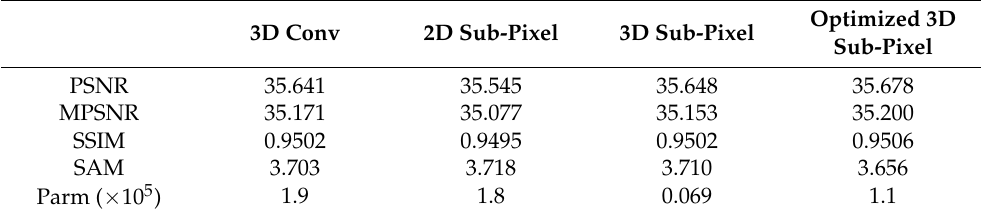
Table 5. Comparison of different reconstruction modules under the same network structure in the Pavia dataset with a scale factor of 2.